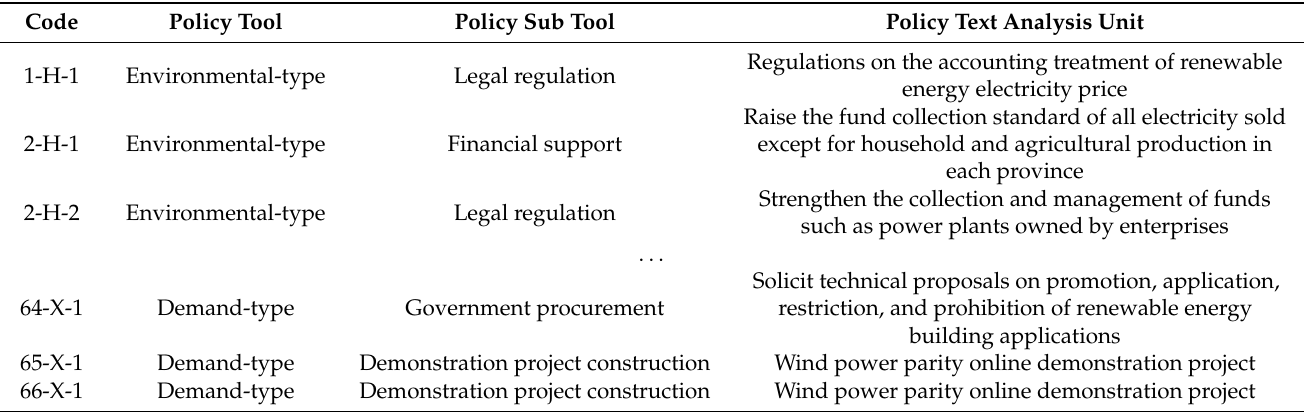
Table 2. Examples of policy text coding and policy tool division.